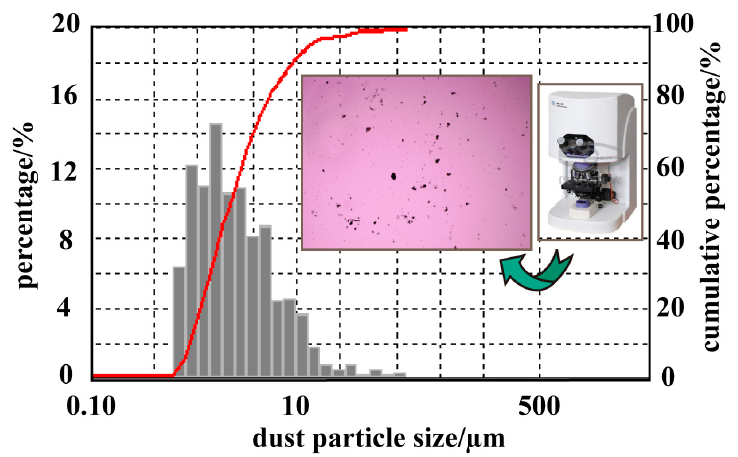
Figure 6. Dust particle size distribution.